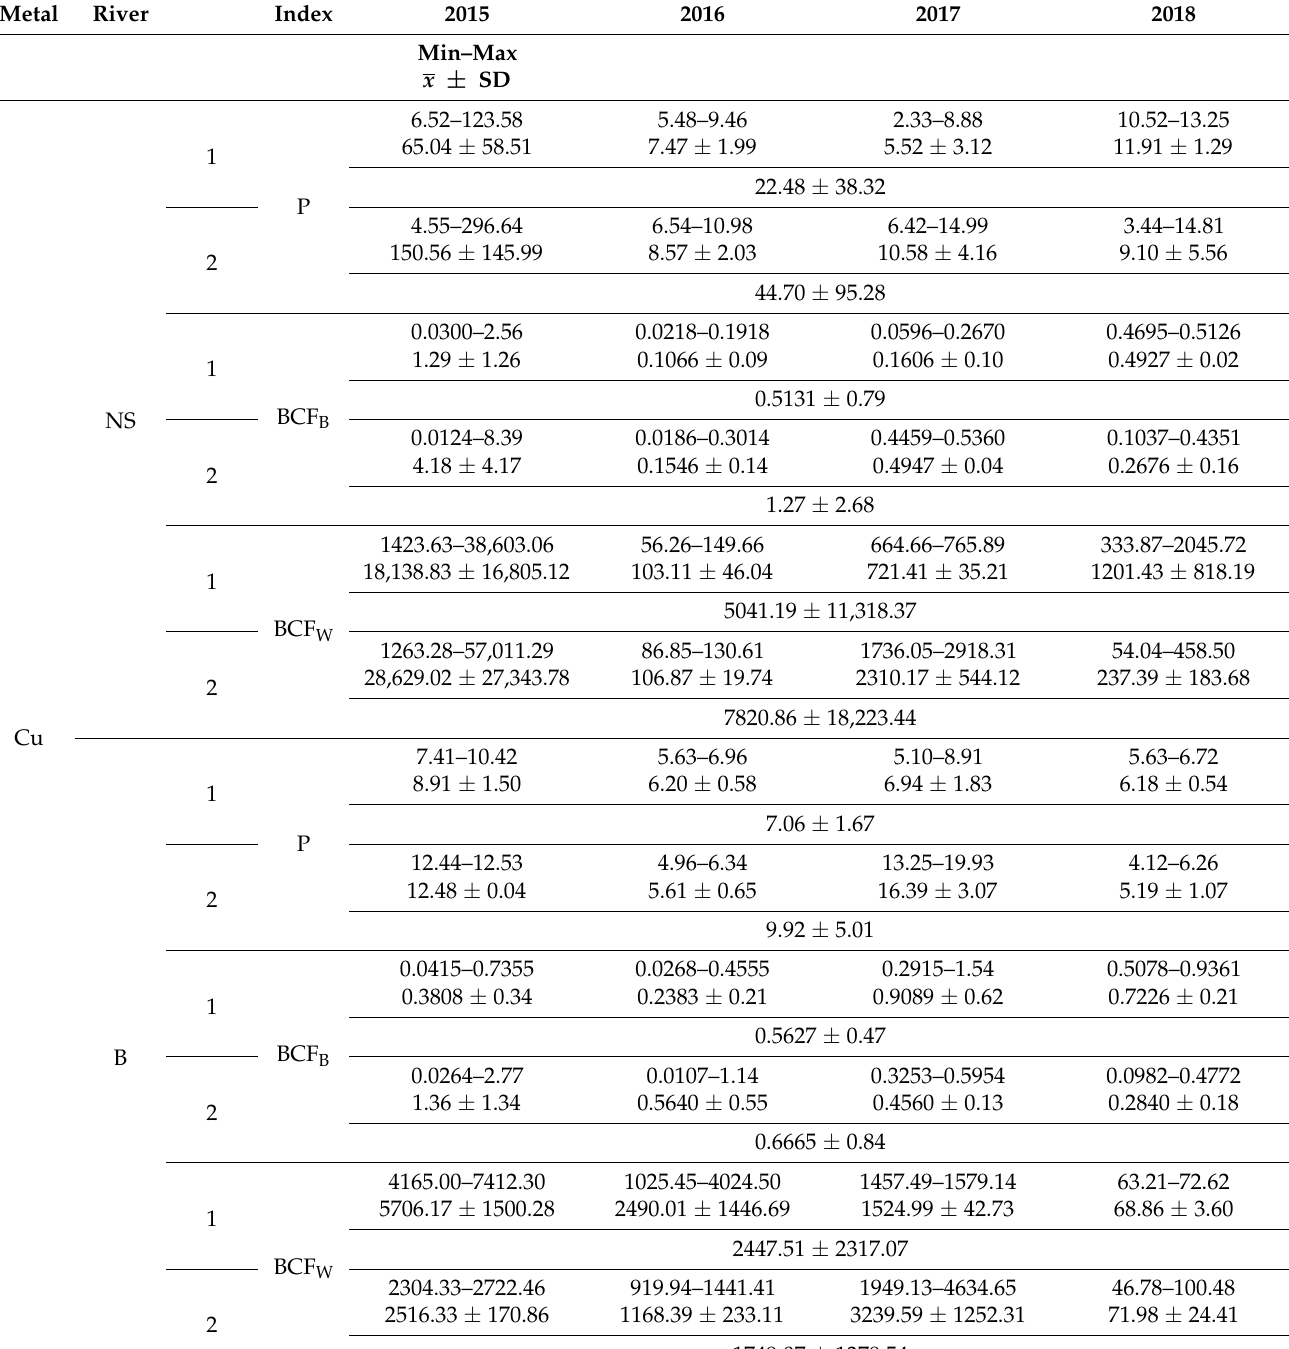
Table 6. Metal content (mg · kg − 1 ) of reed canary grass in three main rivers over a four-year study